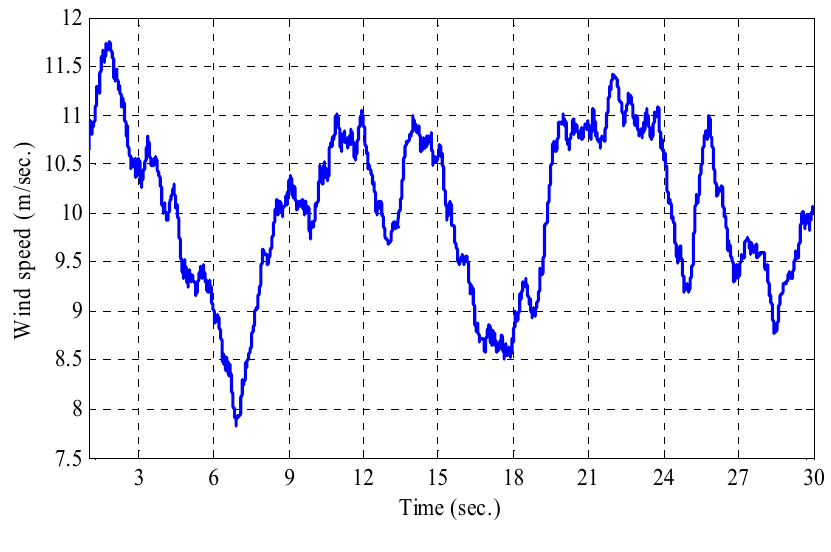
Figure 11. Wind speed variation